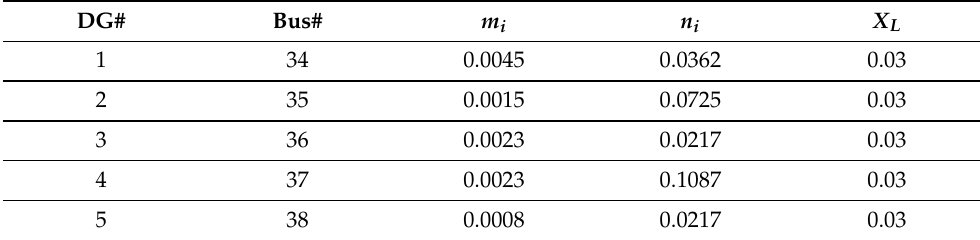
Table 6. Control parameters of the DG in the 38-bus system.